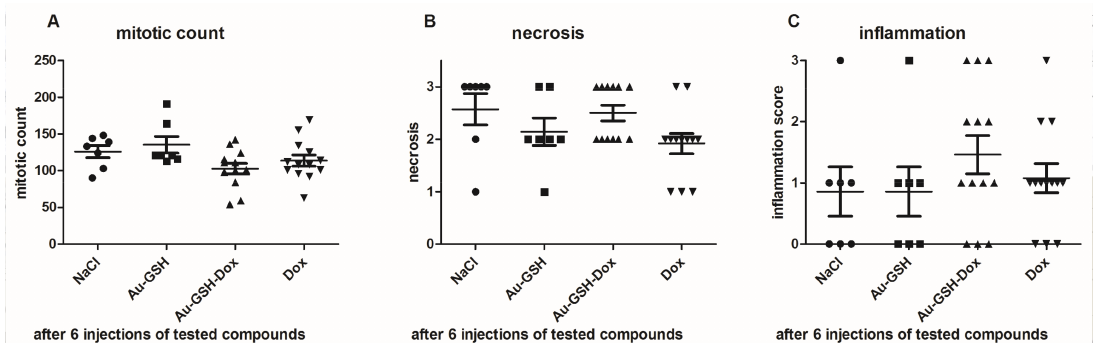
Figure 4. Statistical analyses of mitotic count ( A ), area of necrosis ( B ) and inflammation ( C ) in tumors after six injections of the tested compounds. Results are shown as the mean ± SD.